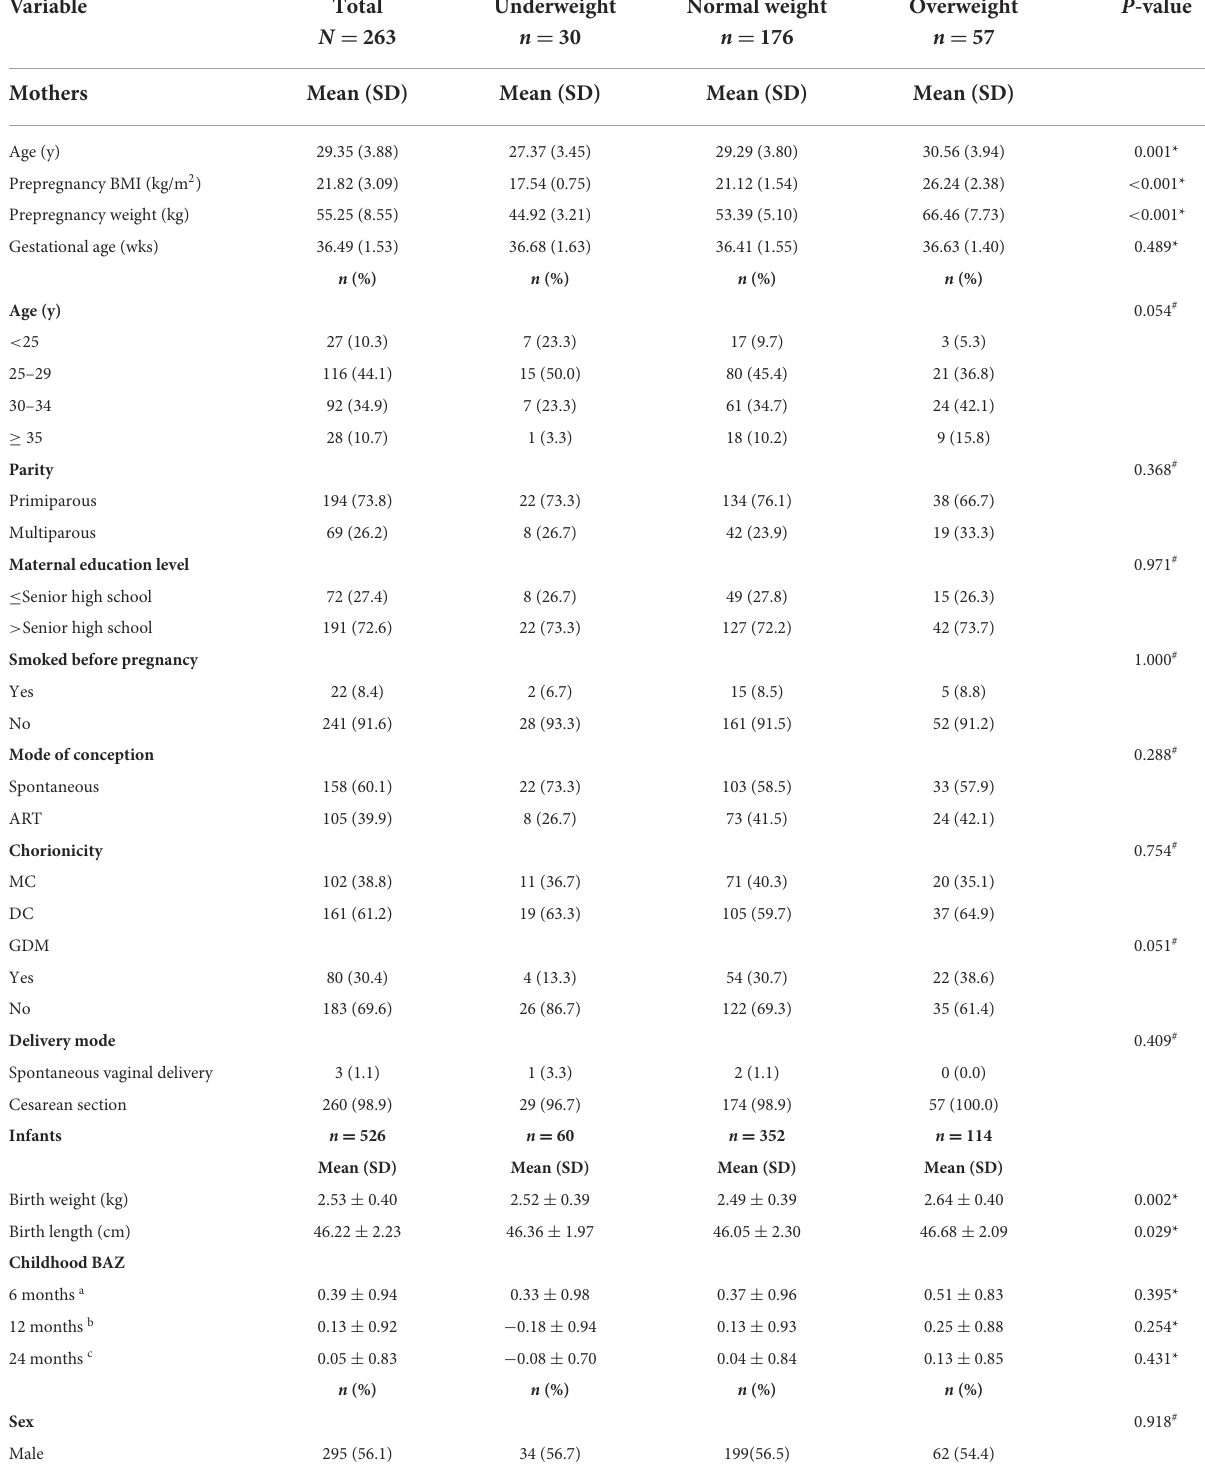
TABLE 1 Basic characteristics of the study population by maternal pre-pregnancy weight